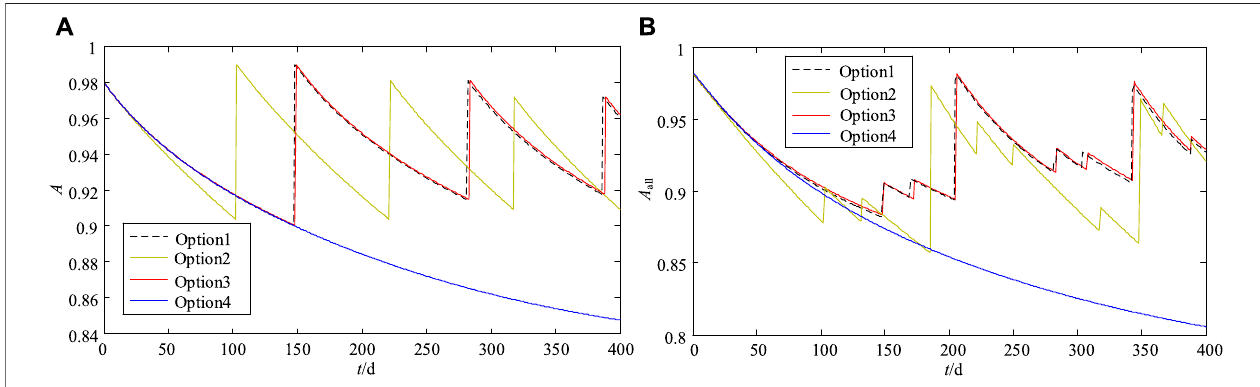
FIGURE 11 | Comparison curve of availability after maintenance. (A) Comparison curve of availability of H 2 after maintenance. (B) Comparison curve of system availability after maintenance.